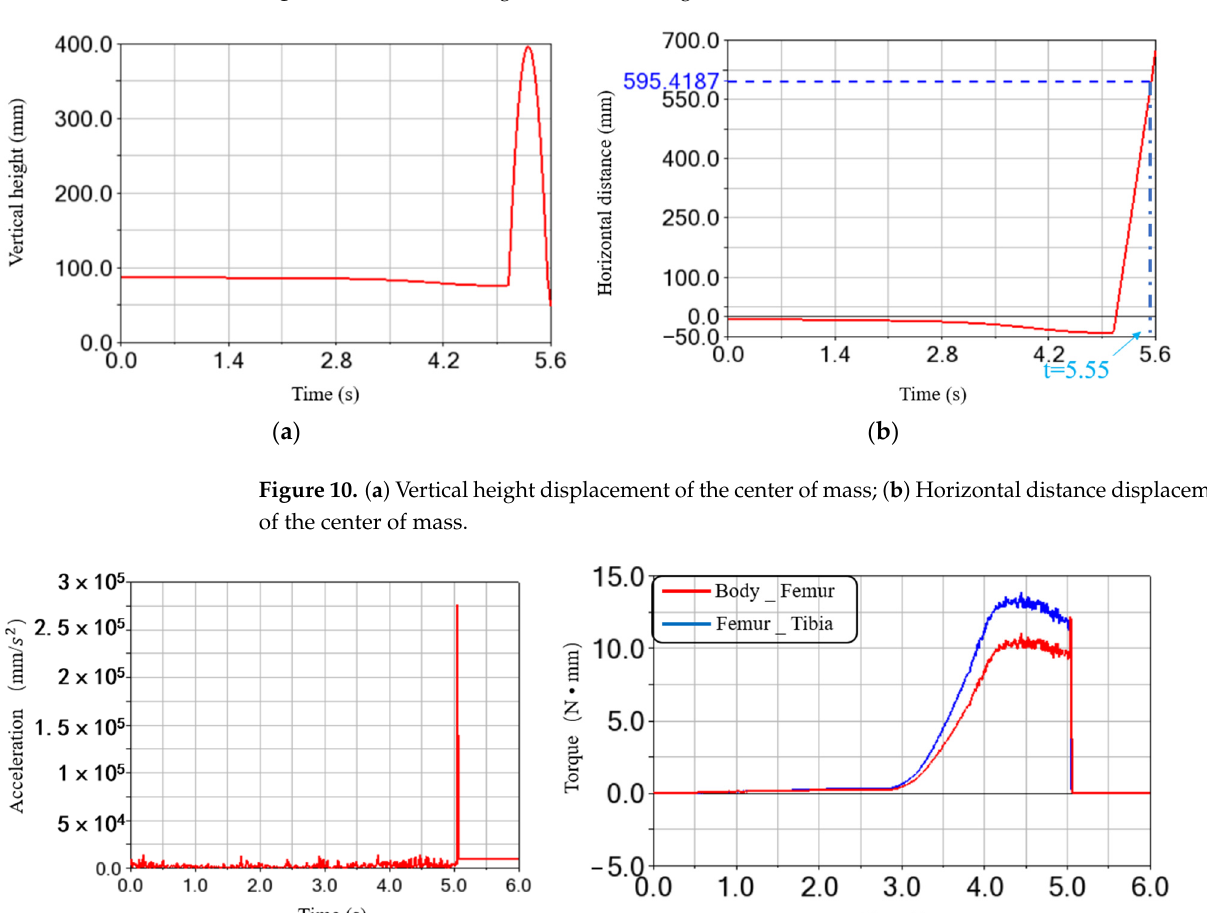
Figure 9. Movement diagram of a bouncing robot in a simulation environment.